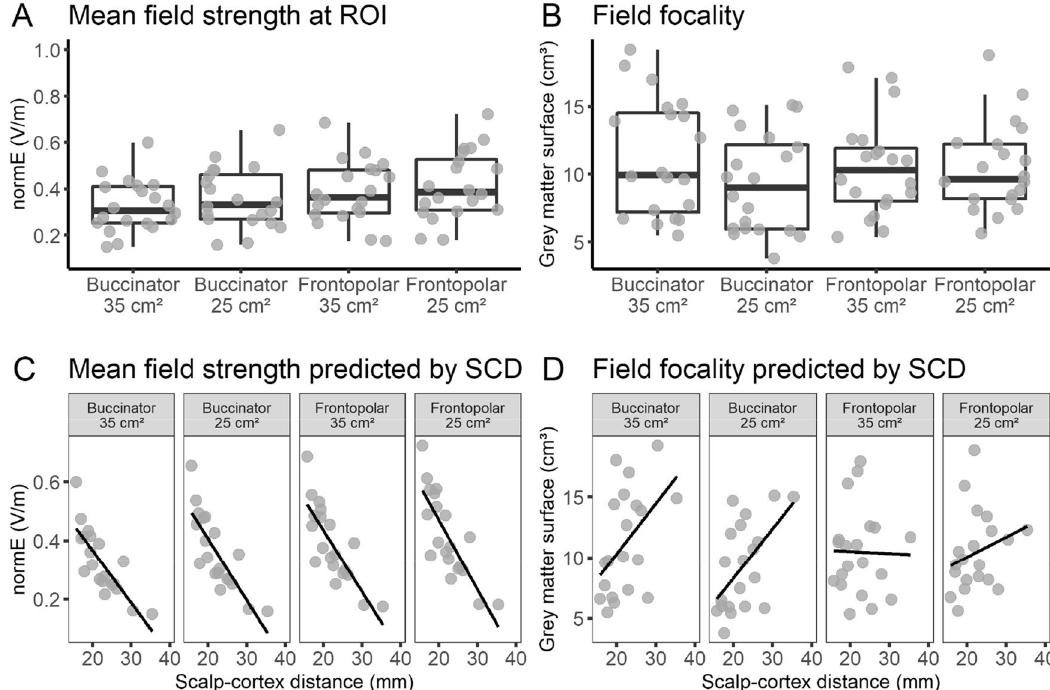
Figure 3. Overview of descriptive values of ( A ) mean field strength and ( B ) field focality for the four conventional montages tested in Experiment 1, as well as their association with individual scalp–cortex distance (SCD; C , D ). Individual points correspond to individual head